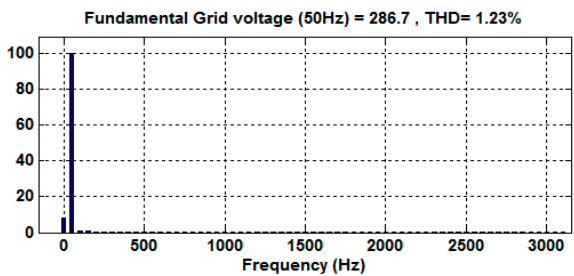
11 of 14 Figure 15. Bode plot for feedback current controller with LCL filter. G PR I Ref + - + - Kdstd tds+1 I lg I g V m V g Figure 16. Block diagram of PR-D controller. PR controller was incorporated in this study to enhance the accuracy of the control system. The important characteristic feature is at resonance frequency to contribute infinite gain. This controller has the ability to compensate known and fixed frequency. Signals that are controlled by PRD controller are given to the PWM. G PR is the transfer function of PR (proportional resonant) controller, which is given as 2 2 21,3,5. 2 K